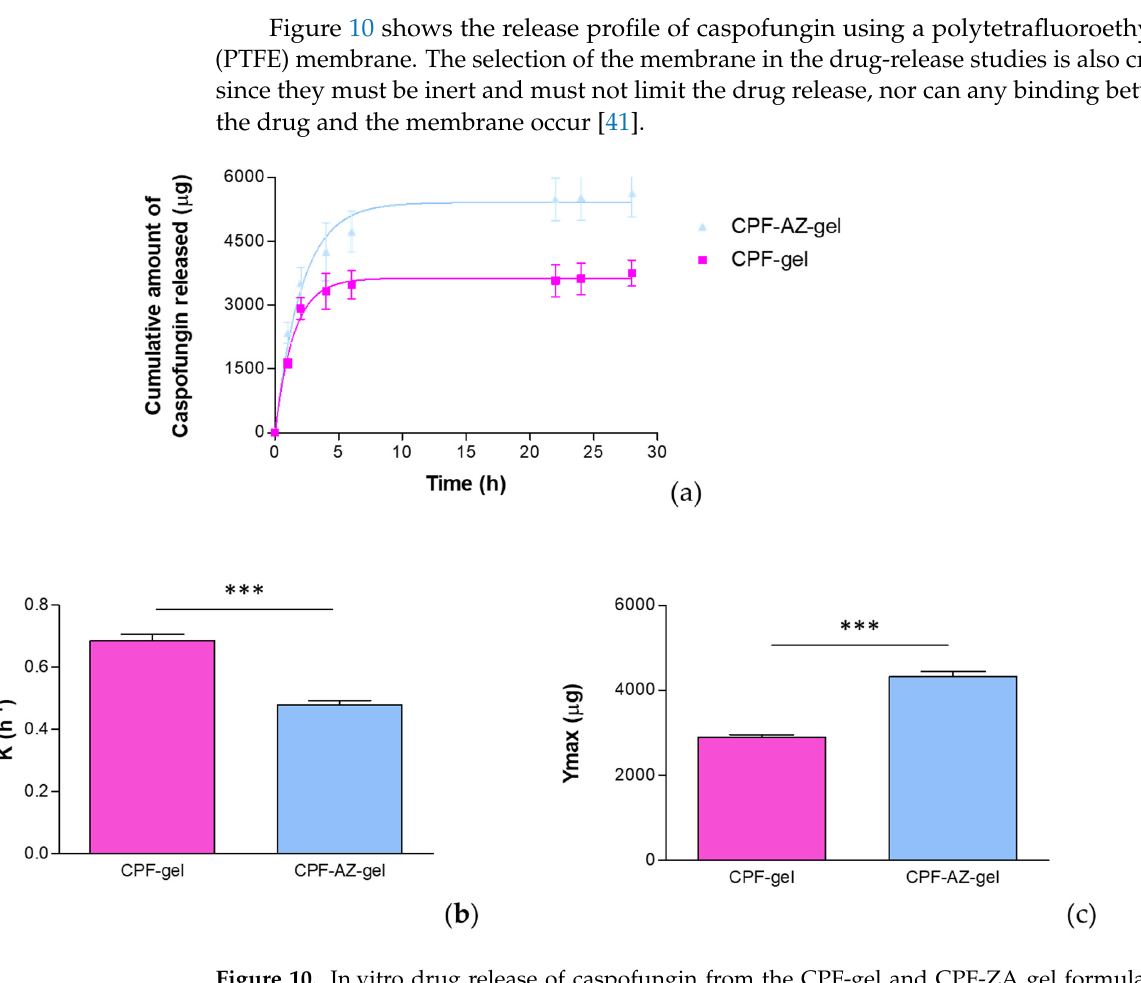
Figure 10. In vitro drug release of caspofungin from the CPF-gel and CPF-ZA gel formulations: ( a ) release profile of caspofungin over time; ( b ) release constant (K), estimated by modeling to the best-fit model, corresponding to a one-phase exponential association model; ( c ) maximum amount released (Y max ) estimated by modeling to the best-fit model, corresponding to a one-phase exponential association model. *** signi fi cant statistical di ff erences between the two gels ( p < 0.0001).